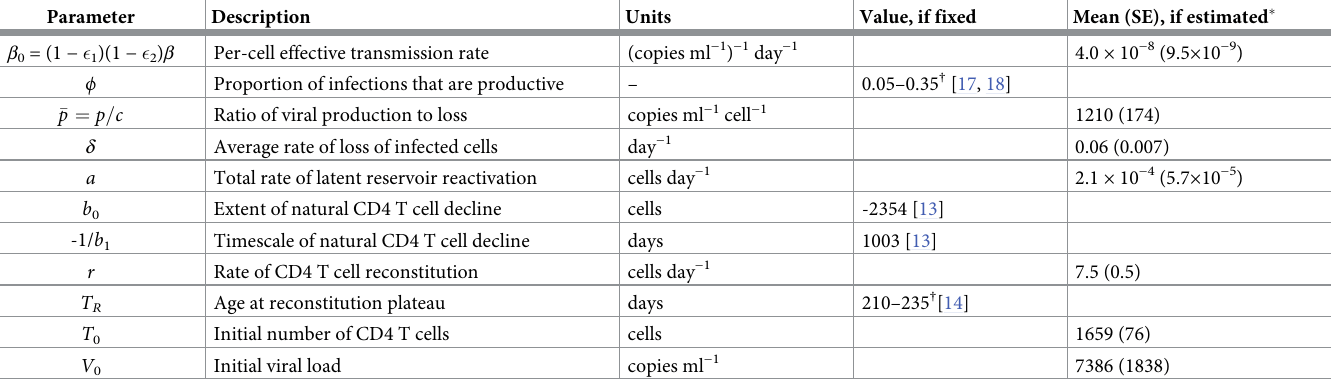
We describe HIV dynamics in an infant on ART using a deterministic ordinary differential equation (ODE) model (Fig 1A) [7, 12]. We assume that CD4 target cells, T ( t ) (measured as the concentration of cells per μ l of blood, but from here on referred to as ‘cells’ or ‘counts’ for brevity), undergo background growth and loss at net rate θ ( t , T ), and are infected by free infec- tious virus, V ( t ), with a per capita transmission rate β (Table 1). During ART this transmission I Table 1. Model parameters and population-level